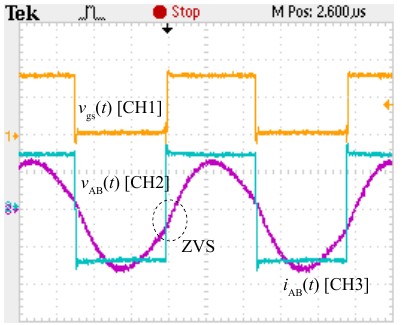
Figure 11. Experimental waveforms of v AB ( t ) and i AB ( t ) .